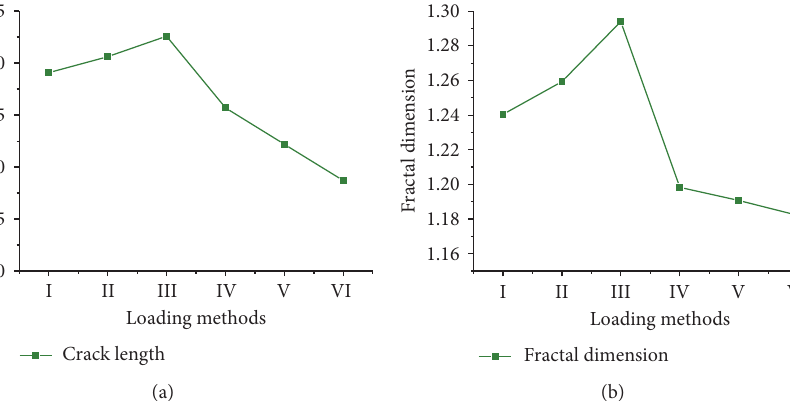
Figure 4: Geometric features of fracture paths under six different loading methods. (a) Crack length; (b) Fractal